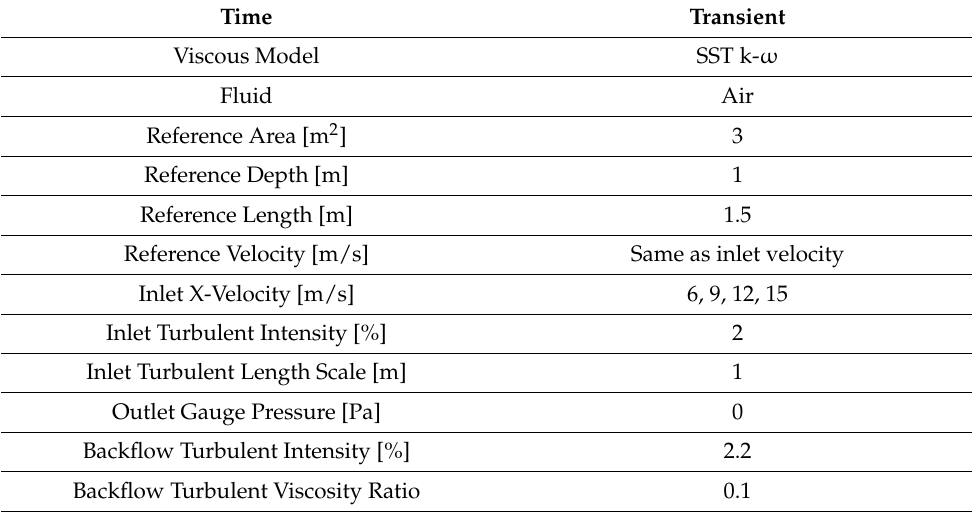
Table 1. Computation fluid dynamics (CFD) setup parameters.